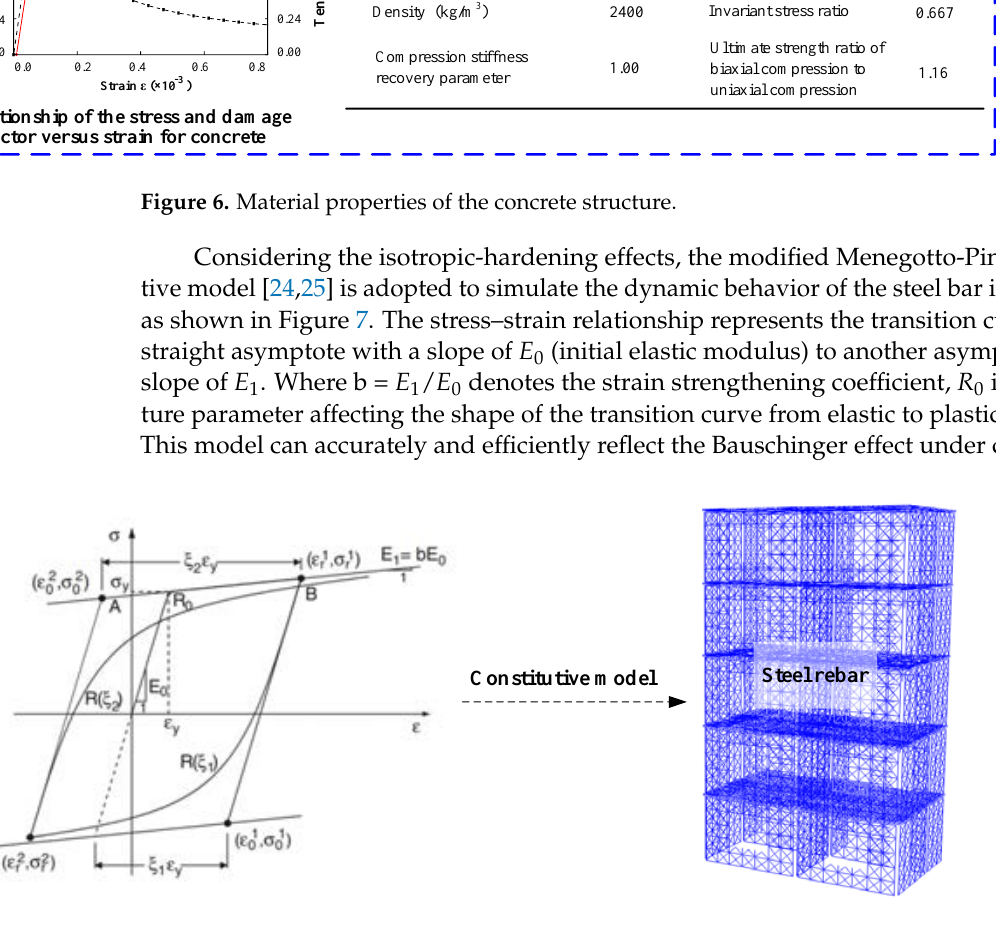
Figure 7. The modified Menegotto-Pinto constitutive model [24].